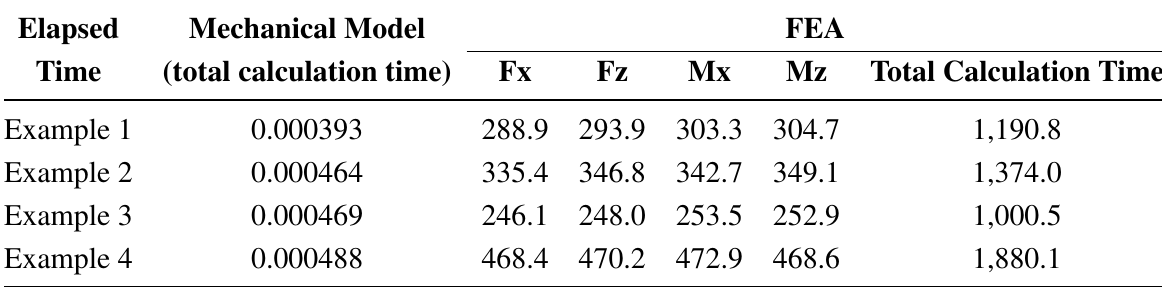
Table 3. Averaged calculation time (in second) of mechanical models and